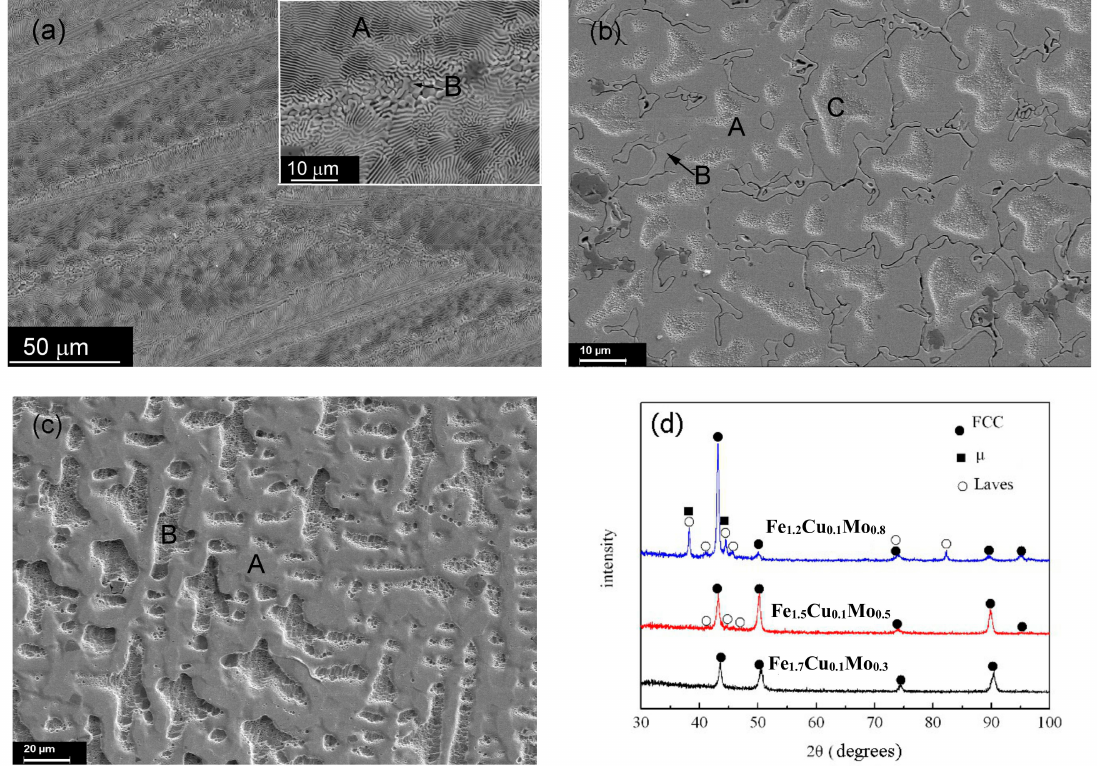
Figure 3. Micrographs and XRD patterns of CoCrCu 0.1 Fe c Mo 2 − c Ni HEAs: ( a ) Cu 0.1 Fe 1.2 Mo 0.8 ; ( b ) Cu0.1Fe 1.5 Mo 0.5 ; ( c ) Cu 0.1 Fe 1.7 Mo 0.3 ; ( d ) XRD